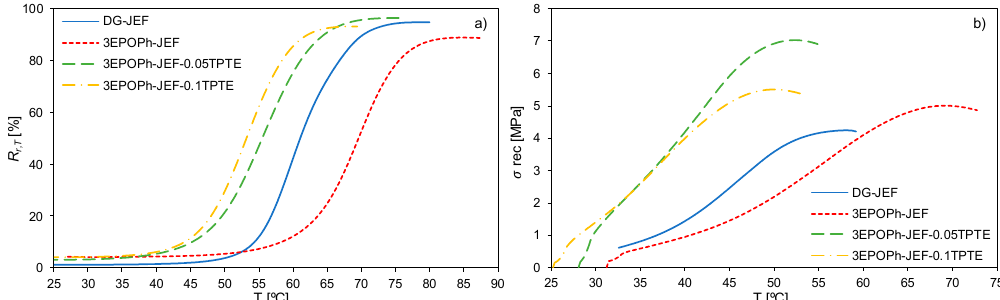
Figure 7. ( a ) Shape-recovery ratio as a function of temperature during the recovery stage under free conditions of all formulations. ( b ) Recovery stress generation as a function of temperature during the recovery stage under constrained conditions of all